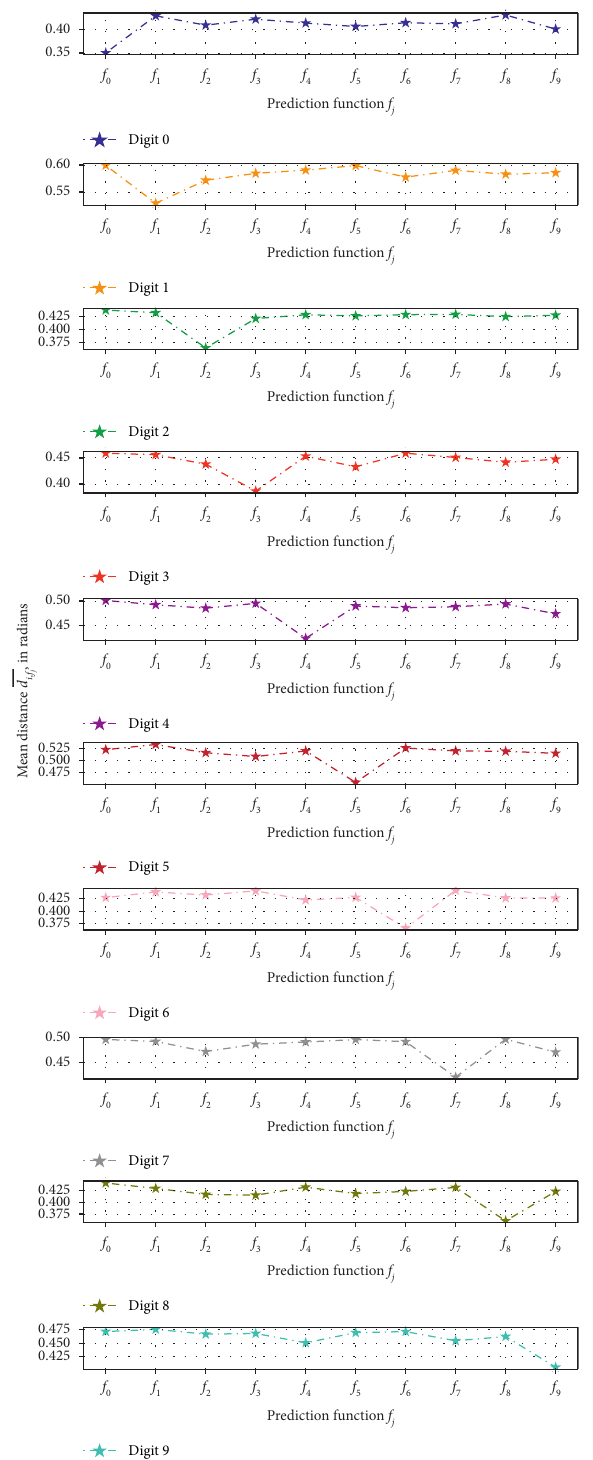
Figure 11: Mean distance d